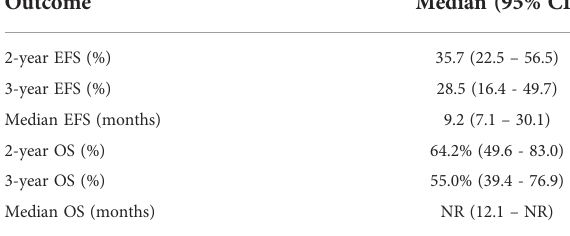
TABLE 3 Event free survival (EFS), and overall survival (OS) of patients with mucosal melanoma treated with neoadjuvant checkpoint inhibitors.